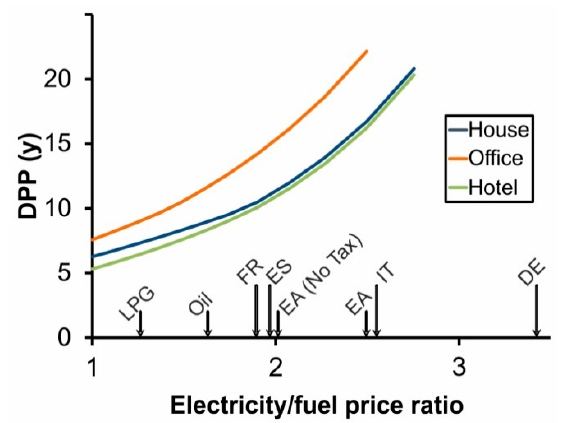
Figure 10. Discounted Payback Period (DPP, [54]) of subsidized GCHP system in low-insulated buildings in Zone E vs. different electricity/fuel price ratio.